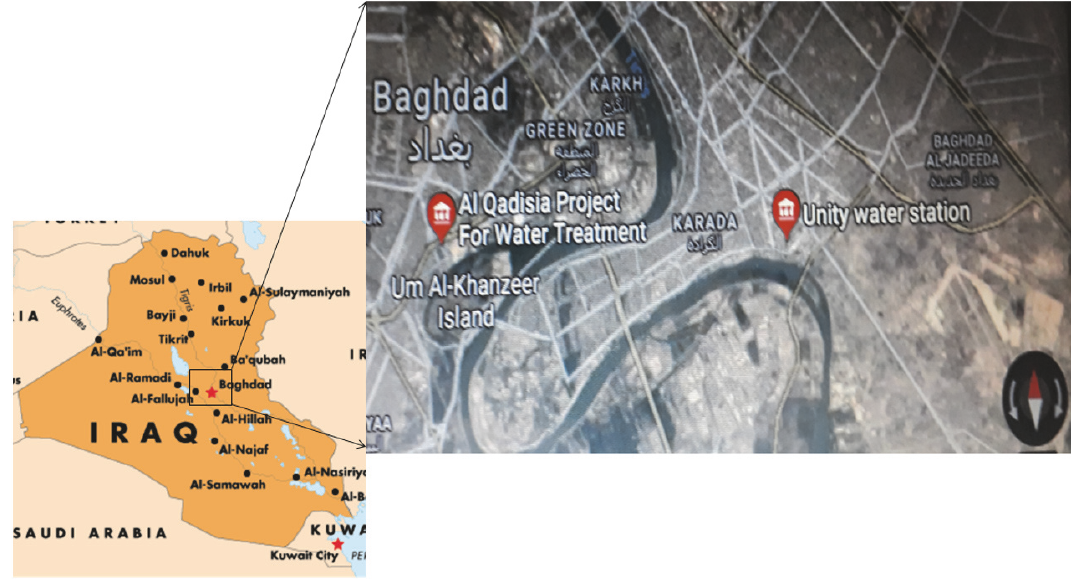
Figure 1: The location of Al-Wihda and Al-Rasheed water treatment plants in Baghdad City. The image is adapted from Google Earth Pro.